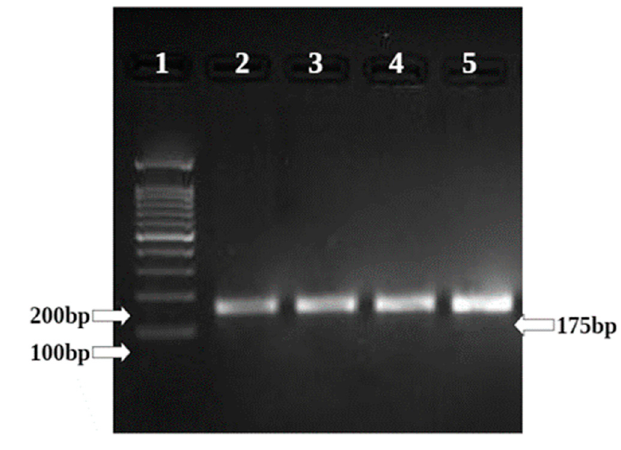
Figure 13. Gene regulation expression of BAX in HepG2 cell line. Table 5. Relative expression of BAX gene treated with Ashwaganda in HepG2. HepG2 Sample Conc.